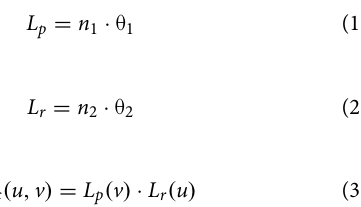
location. The activity index is used to measure the total activity of two users in Sina Weibo, and the influence index is used to measure the influence of the two users as the object of